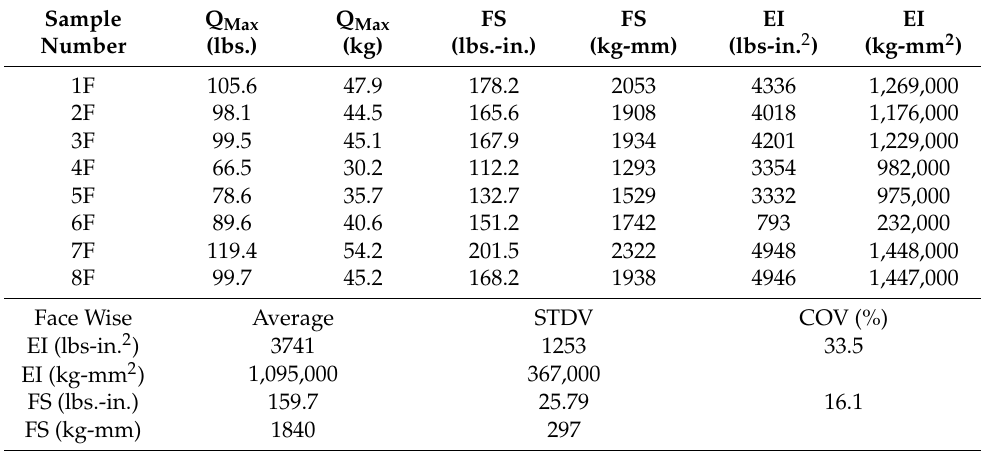
Table 1. Maximum Load at failure, Strength, and stiffness of Face Wise Strips tested in bending.